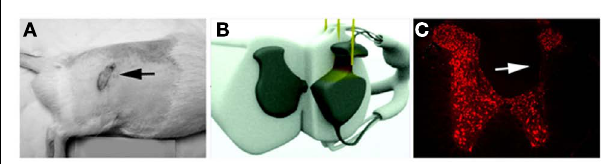
FIGURE 1 | Overgrooming lesions were primarily observed on at-level ipsilateral dermatomes two weeks after lesion [(A): black arrow]. (B) A 3D model of spinal cord showing three injections of approximate 1mm in depth from the dorsal surface needed to induce overgrooming in QUIS animals. (C) Characteristic loss of spinal neurons (Neu-N immunoreactivity) in the neck of dorsal horn 2 weeks after QUIS injection (white arrow). Neurons from the superficial lamina I and II are mostly spared from the excitotoxic cell